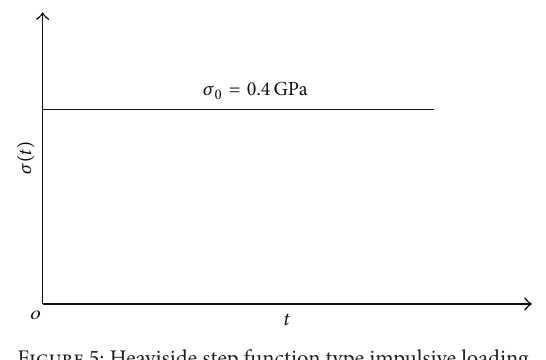
Figure 5: Heaviside step function type impulsive loading.